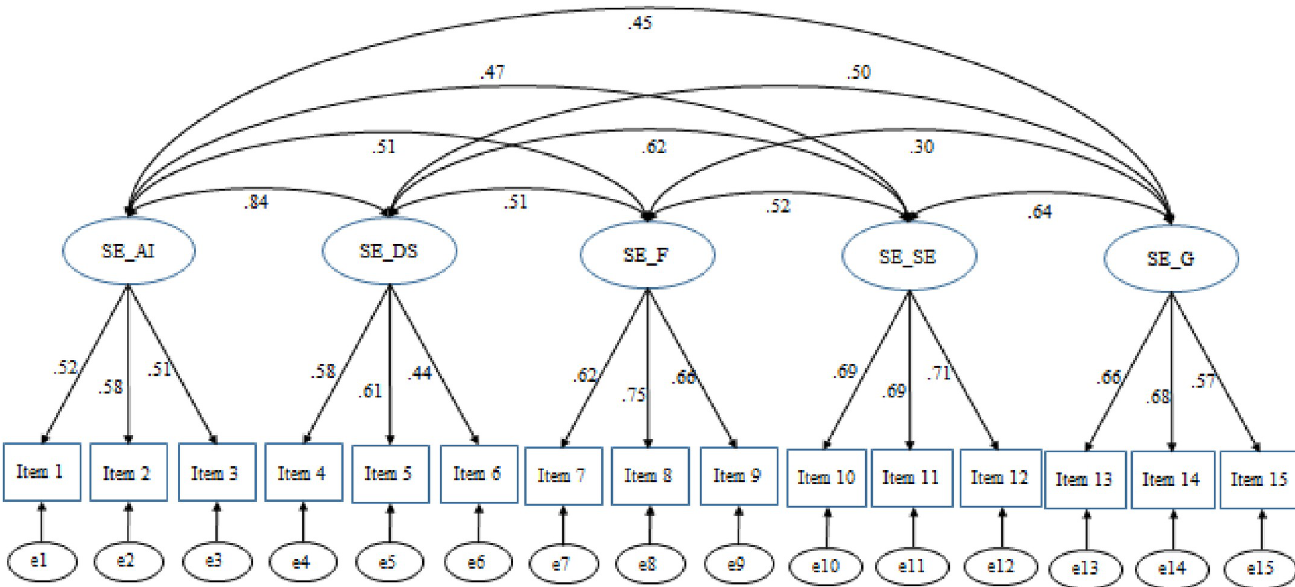
Fig 1. Path diagram of the best factorial solution of the MNESRES in a Spanish context. The labels in the first order factors refer to the five subscales designed to assess self-efficacy beliefs regarding managing anger/irritation, despondency/sadness, fear, shame/embarrassment, and guilt ( SE_AI , SE_DS , SE_F , SE_SE , SE_G , respectively). e1–e15 represent error terms. Standardized factor loadings are shown on the straight arrows. All the paths are significant with p-value < .001.